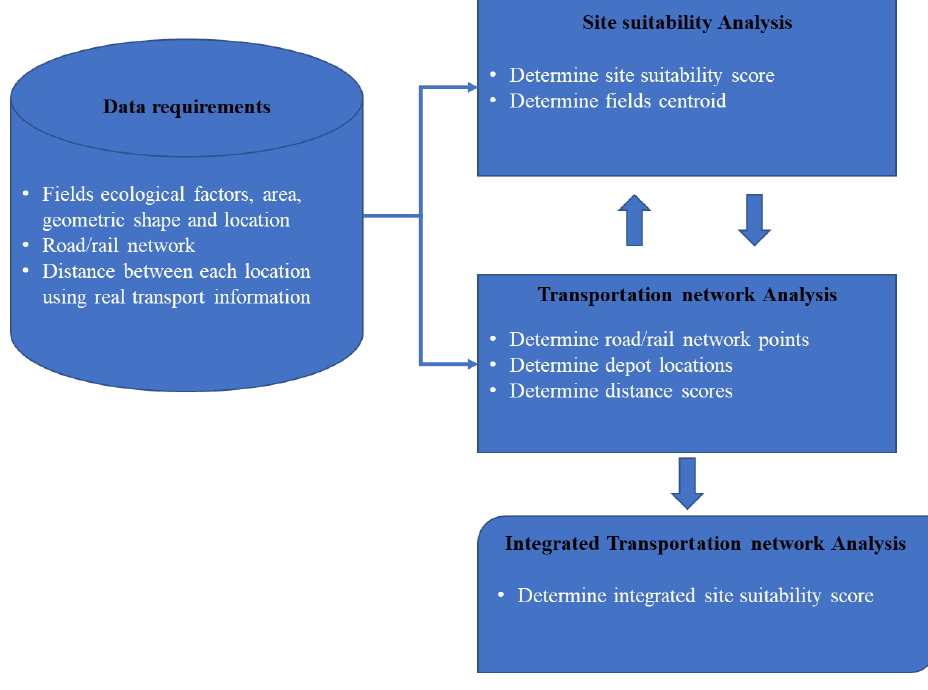
Figure 3. Methodology schematic.